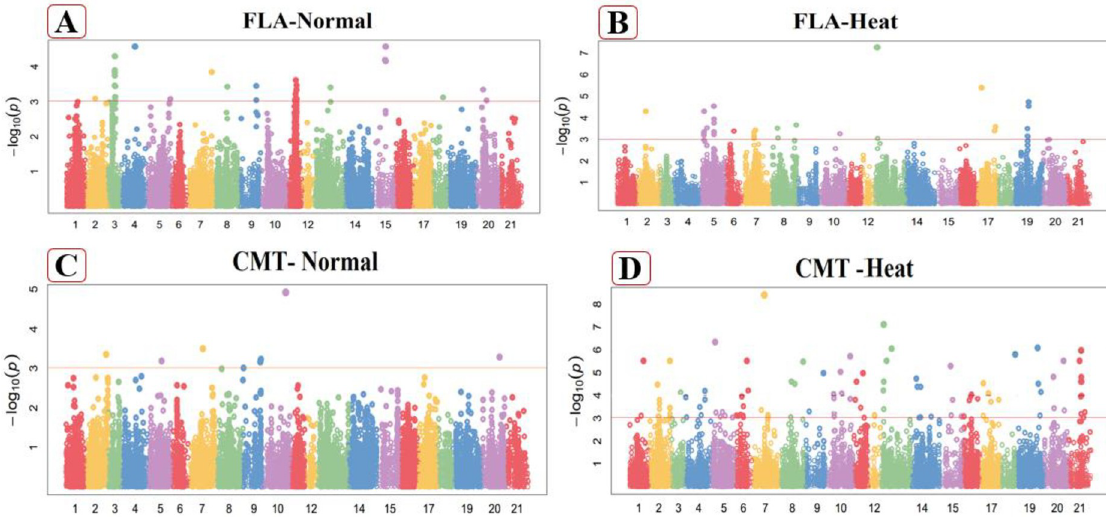
Fig 1. Manhattan plot of Flag leaf area (FLA) in normal ( A ), heat stressed ( B ) conditions and Cell membrane thermostability (CMT) in normal ( C ) heat stressed ( D ) conditions. These figures exhibiting the position of significant SNPs and -log10(p) linked with specific traits in normal and heat stressed